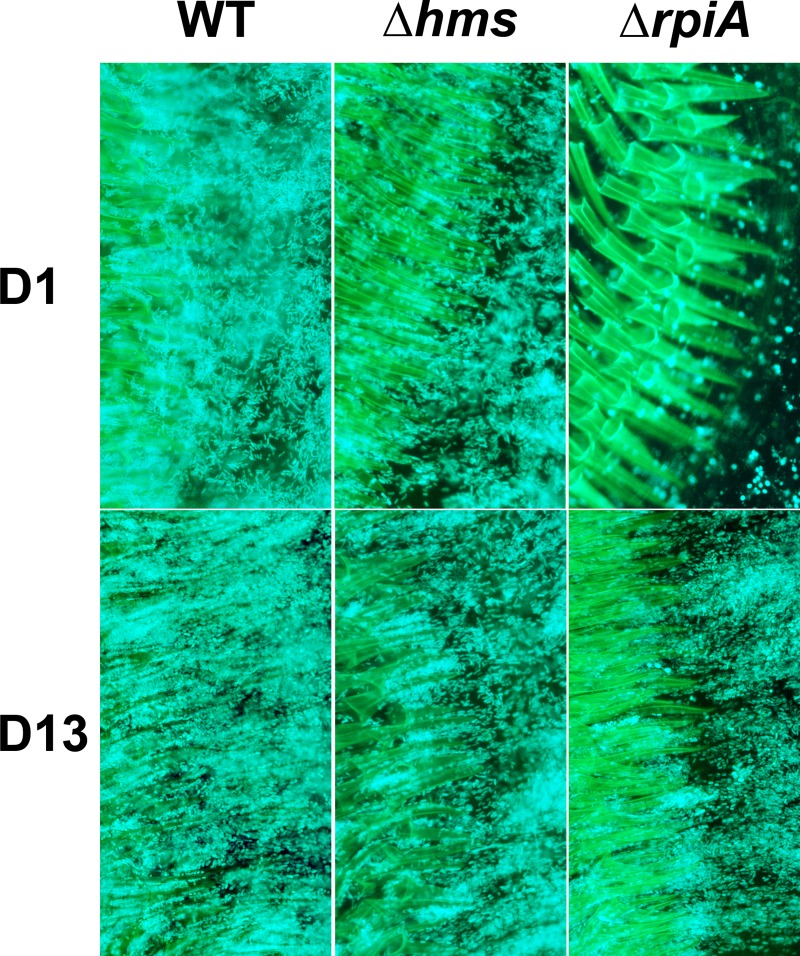
rpiA (but not hms) is needed to maintain a normal bacillary shape during the early (but not late) colonization of the mass anchored within the proventriculus.Fluorescence microscopy images show the presence of WT, Δhms or ΔrpiA bacteria (in blue) in the brownish mass anchored within the proventriculus (PV, green spines) on day (D)1 and D13 post-infection. Images were post-processed using the curve adjustment tool in Adobe Photoshop, in order to highlight the bacteria (in blue) and the PV’s spines (in green).